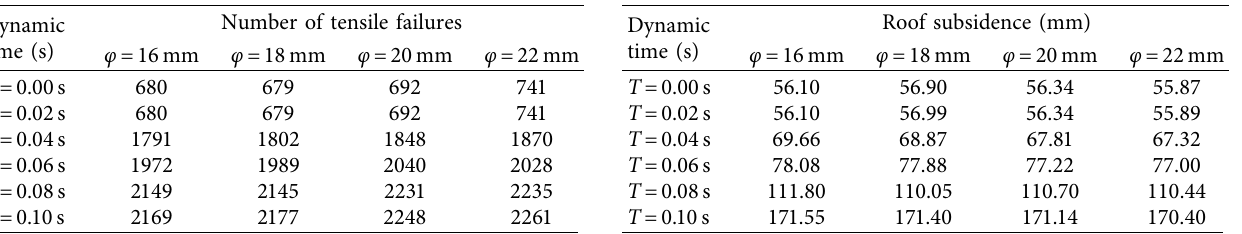
Figure 7: Roadway tensile failure distribution with different rock bolt diameters: (a) T � 0 s; (b) T � 0.1s. Table 8: Number of tensile failures with different bolt diameters. Table 9: Roof subsidence with different bolt